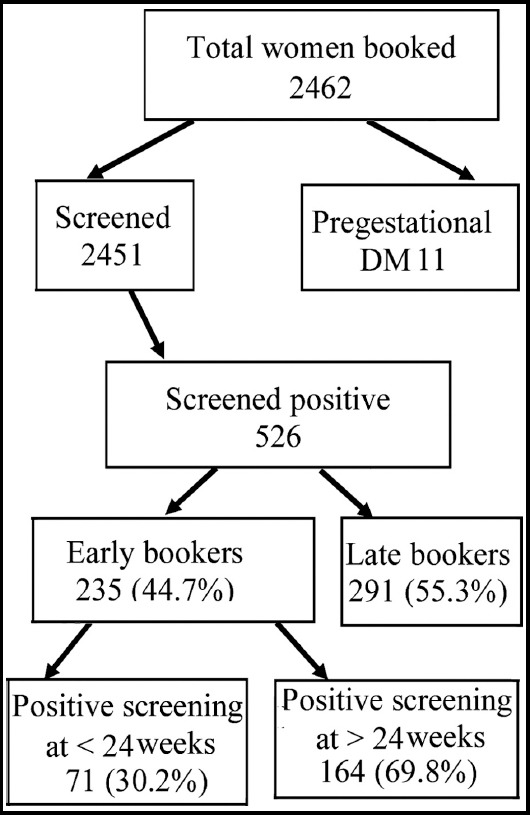
Flow-diagram showing the diagnosis of diabetes in pregnancy with early vs. late booking.